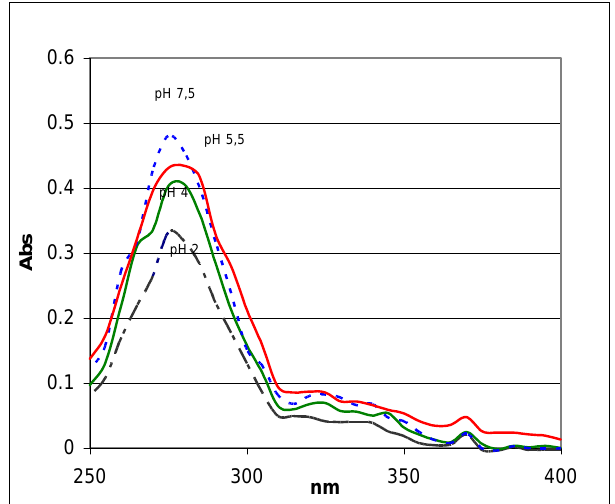
Figure 3. UV-Vis spectra of complex 1 at different pH